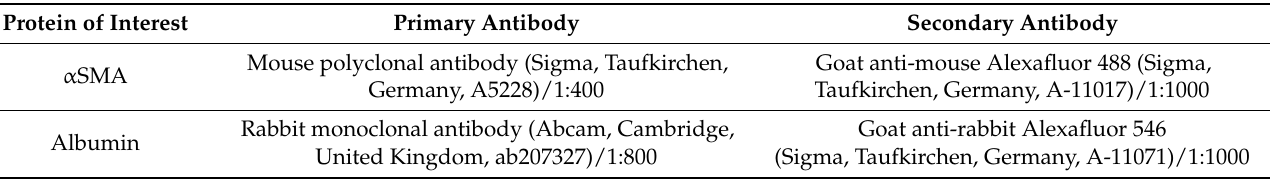
Table 1. Antibodies used for immunohistochemistry.